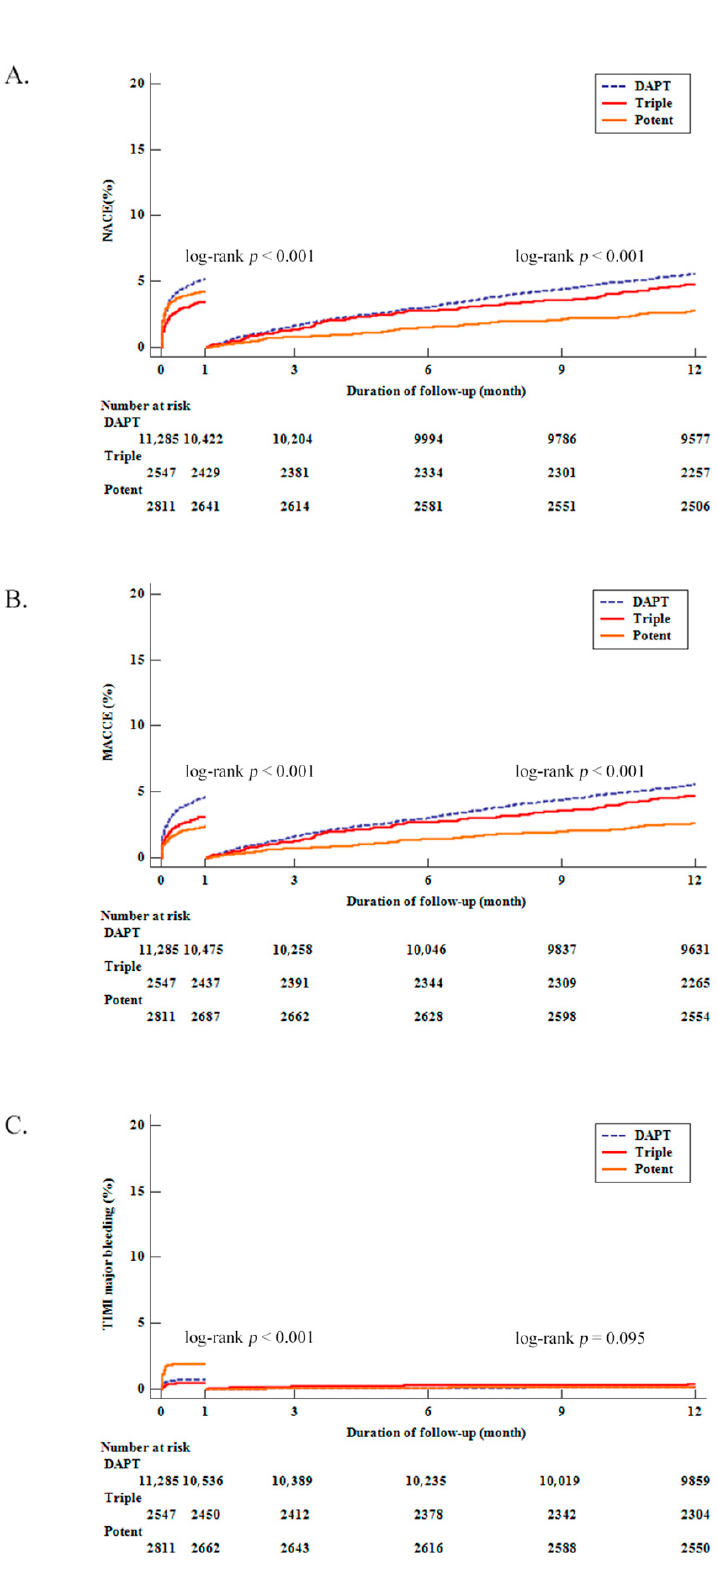
Figure 2. The twelve-month Kaplan–Meier curves and one-month landmark analysis of clinical outcomes based on antiplatelet combination. ( A ) NACEs ( B ) MACCEs ( C ) TIMI major bleeding.